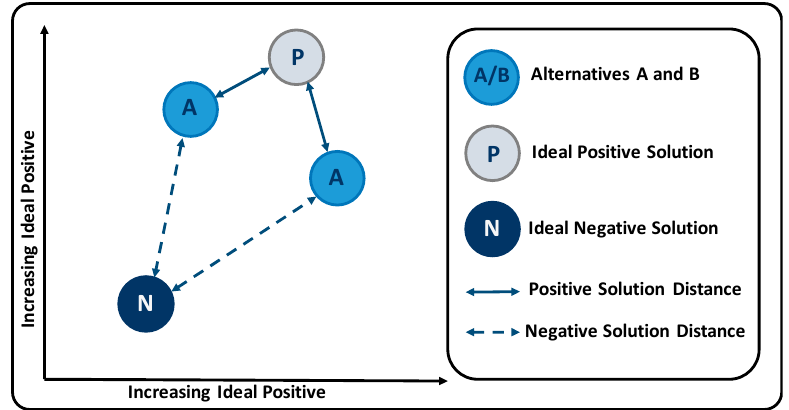
Figure 3. Distance of the alternative solutions from the positive and negative ideal solution.